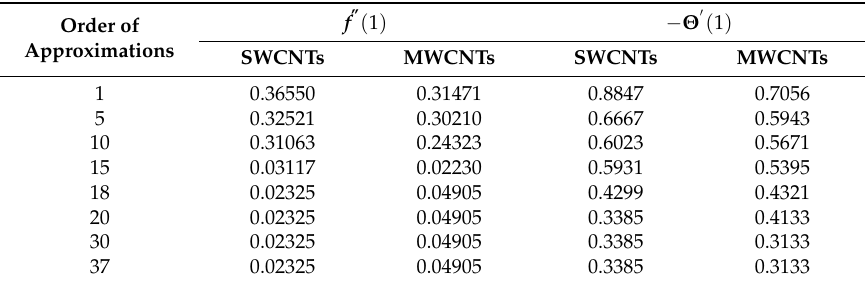
Table 2. The convergence of the Homotopic results for different orders of estimation.